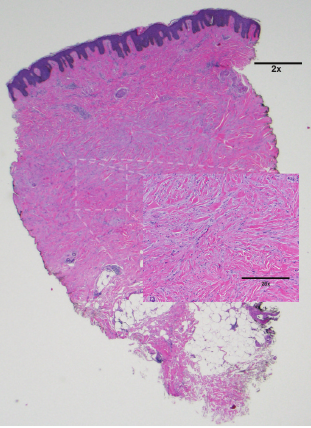
Figure 2: Keloidal scleroderma. Histologic sections show an acan- thotic epidermis with overlying basilar hyperpigmentation. Within the dermis there is a proliferation of myofibroblasts and thickened collagen bundles. There is a lack of vertically oriented blood vessels and a lack of atrophy of the overlying epidermis speaking against that of a keloid or scar. At low power (2x) biopsy has a barrel-shaped appearance.Thedermalcomponentisexpansileandextendsbeyond that of the epidermal component.